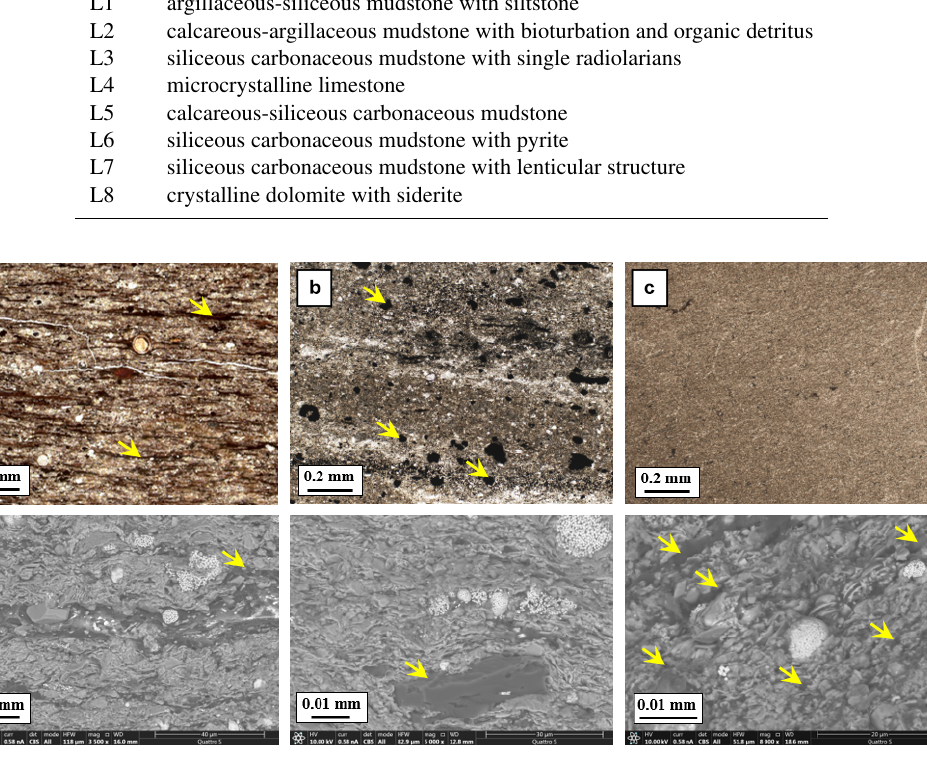
Figure 2. Primary shapes of OM in rock samples by results of thin section microscopy and SEM (arrows indicate the OM inclusions, C – dispersed OM promotes brown color).